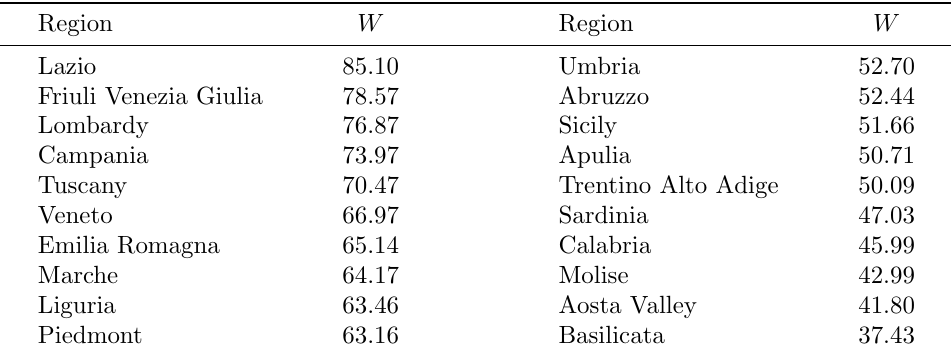
Table 4: Ranking of Italian regions by